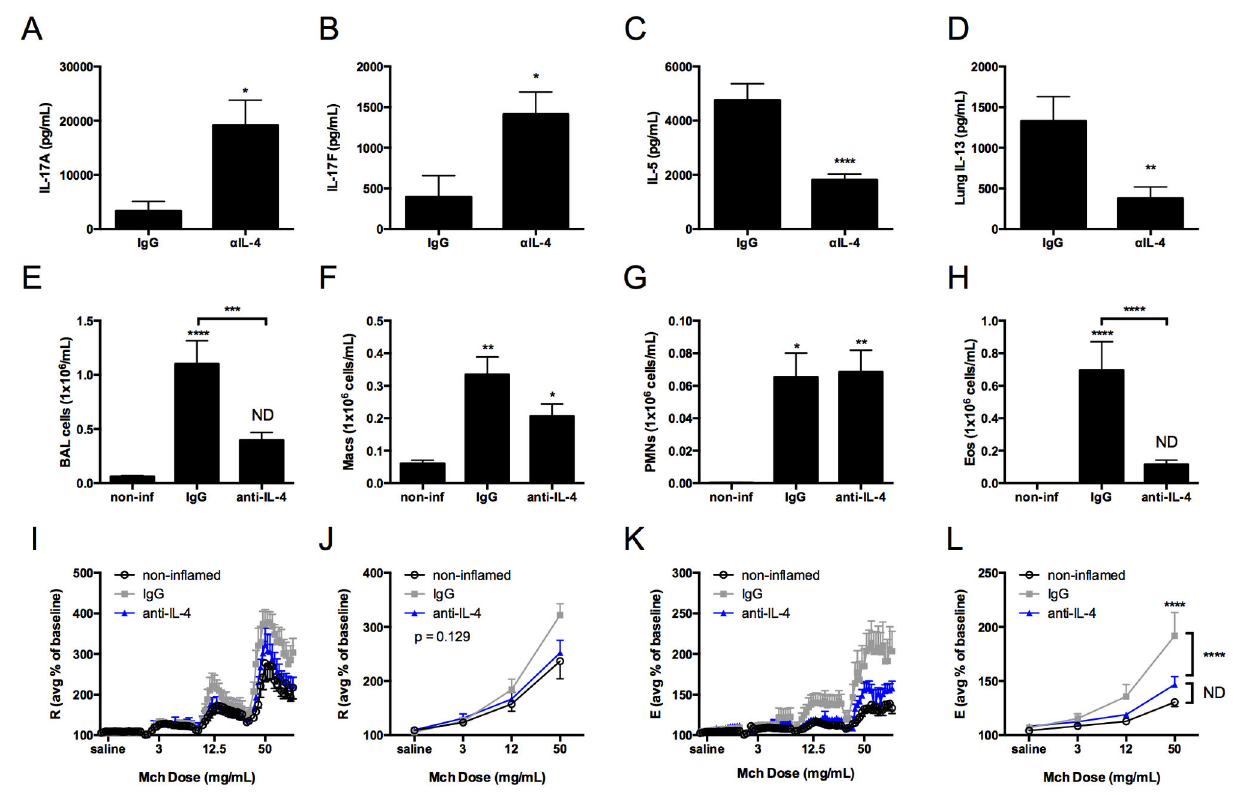
Figure 2. Inhibition of the Th2 response potentiates IL-17A and IL-17F production but is not sufficient to exacerbate neutrophil recruitment or AHR development. Mice were exposed to 15ppm NO for 1 hour on day 1. All mice were exposed to 2 OVA on days 1-3 and again during challenge on days 14-16 and analyzed 48 hours after the final antigen challenge. IgG isotype control antibody was administered one day prior to NO exposure and one day prior to OVA challenge. Anti IL-4 neutralizing 2 antibody was administered one day prior to sensitization on day 0. A second group also received anti-IL-4 antibody one day prior to OVA challenge on day 13. Because we observed no differences in AHR, BAL cell counts, or cytokine production between mice that received anti-IL-4 at sensitization only on day 0 or on day 0 and day 13, we combined anti-IL-4 treated mice for statistical analysis. 48 hours following the final antigen challenge, lungs were removed and enzymatically digested. Single cell suspensions were restimulated in the presence of 200 μg/ml OVA antigen for 96 hours prior to the harvesting of cell supernatants and analysis of cytokine production. IL-17A (A) and IL-17F (B) were quantitated by Milliplex. IL-5 (B) and IL-13 (C) were quantified by ELISA. BAL methacholine were calculated for R (I-J) and E (K-L). Statistics were performed by student’s t-test (A-D), 2-way ANOVA (J and L)